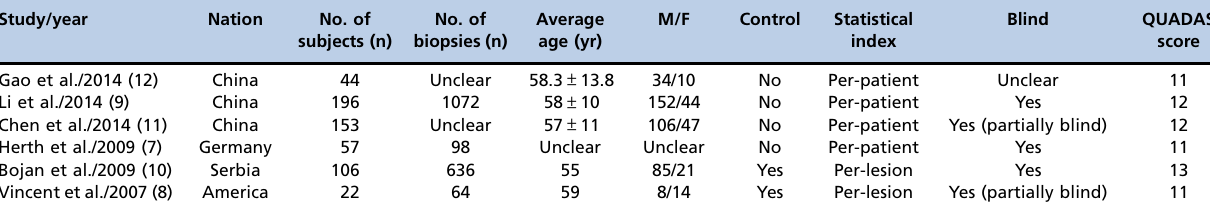
Table 1 - Characteristics of the studies included in this meta-analysis